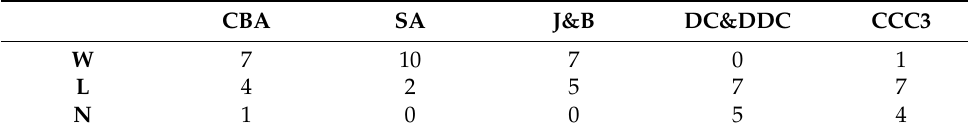
Table 8. Statistically significant wins/losses counts of CCC2 method on the number of rules.